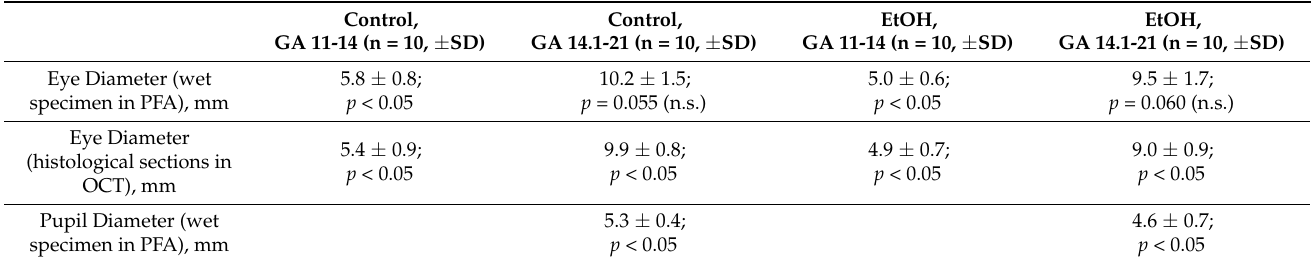
Table 3. Prenatal alcohol exposure inhibits fetal eye development in human fetuses (GA 14-21 weeks, 2nd trimester): Comparative measurements of human fetal eye structure. A digital caliper was used to measure the eye diameter and pupil size in wet tissues fixed in paraformaldehyde (PFA) and frozen sections in Tissue-Tek OCT in EtOH-exposed samples and unexposed controls. For each group, eyes and pupils were measured, and the mean diameter was used for the calculations in the